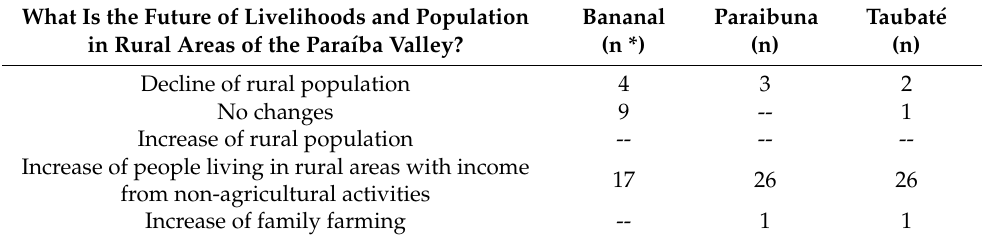
Table 6. Question addressed to interviewees about future expectations on rural livelihoods. What Is the Future of Livelihoods and Population in Rural Areas of the Para í ba